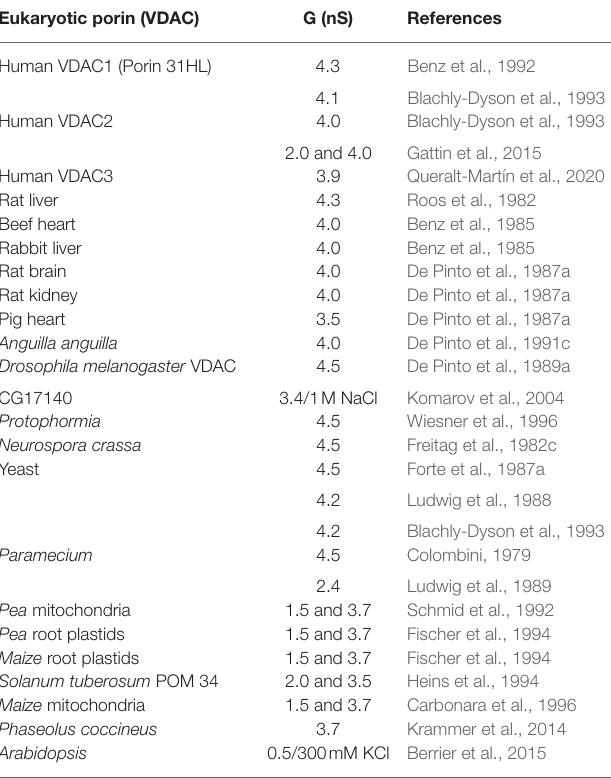
TABLE 1 | Single-channel conductance of eukaryotic (mitochondrial) porins (VDACs) from different eukaryotic organisms in 1 M KCI, pH 6, if not indicated